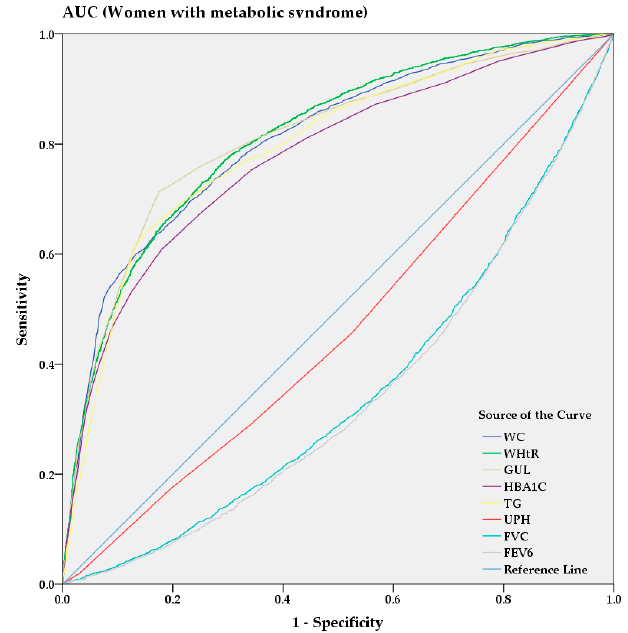
Figure 4. AUC analysis of metabolic syndrome in women.